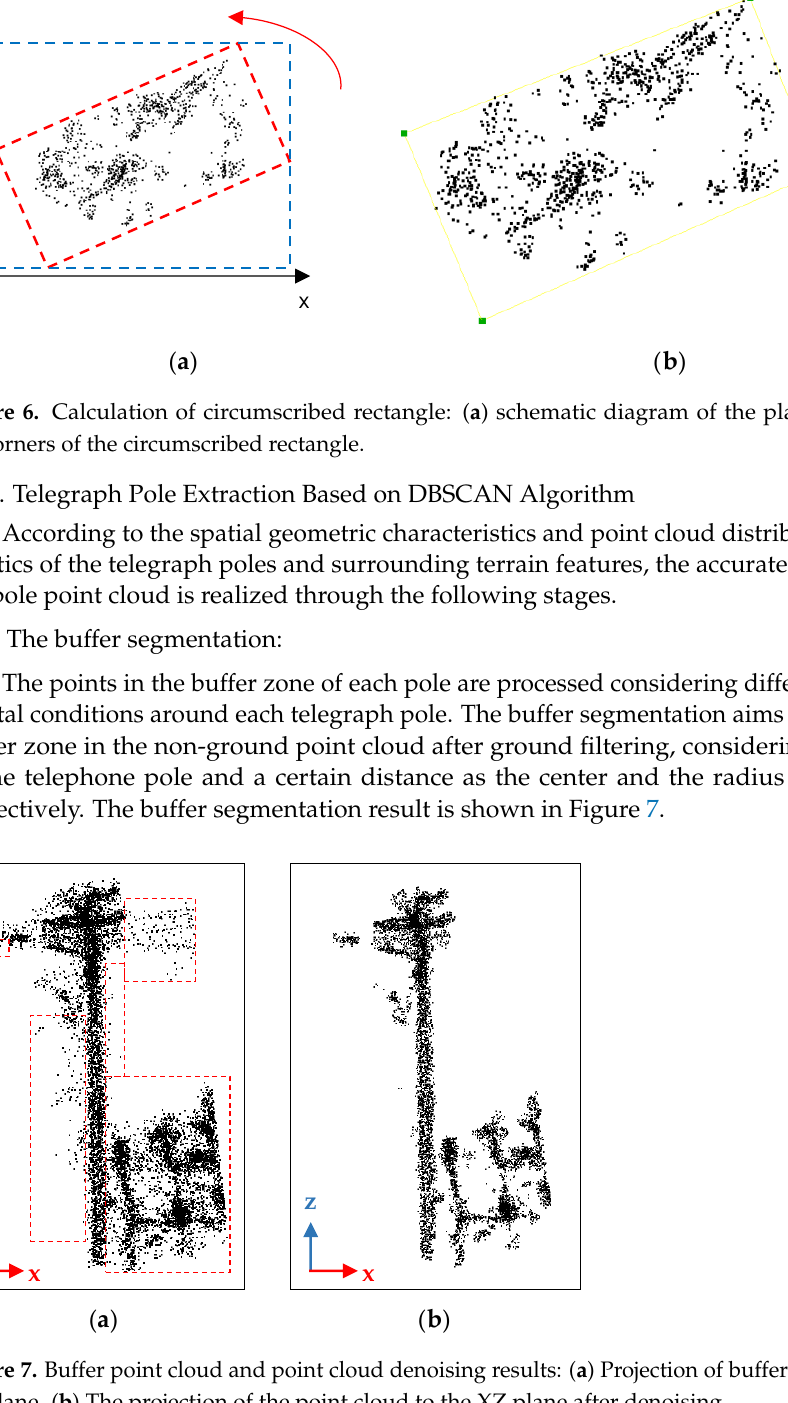
Figure 6. Calculation of circumscribed rectangle: ( a ) schematic diagram of the plane projection; ( b ) corners of the circumscribed rectangle.